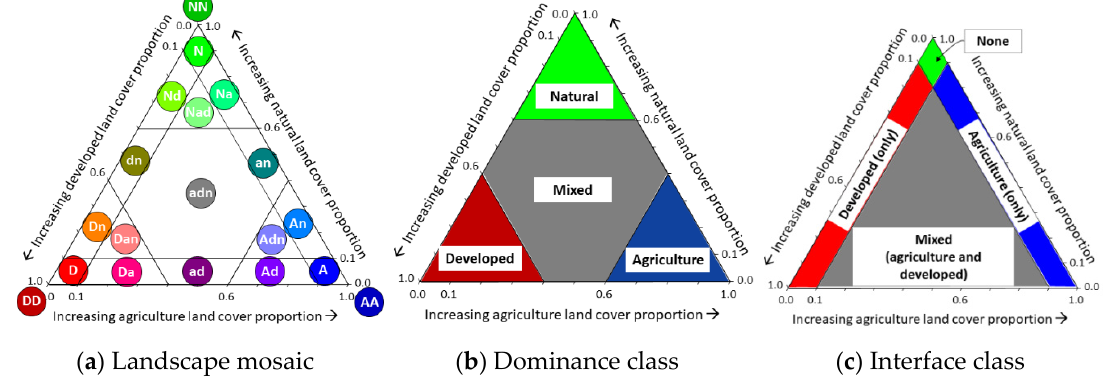
Figure 1. The landscape mosaic classification identifies 19 landscape mosaic classes ( a ), four landscape dominance classes ( b ), and four interface classes ( c ). The color assigned to a mosaic ( a ) is based on the proportions of developed (red), natural (green), and agriculture (blue) land in that mosaic class.